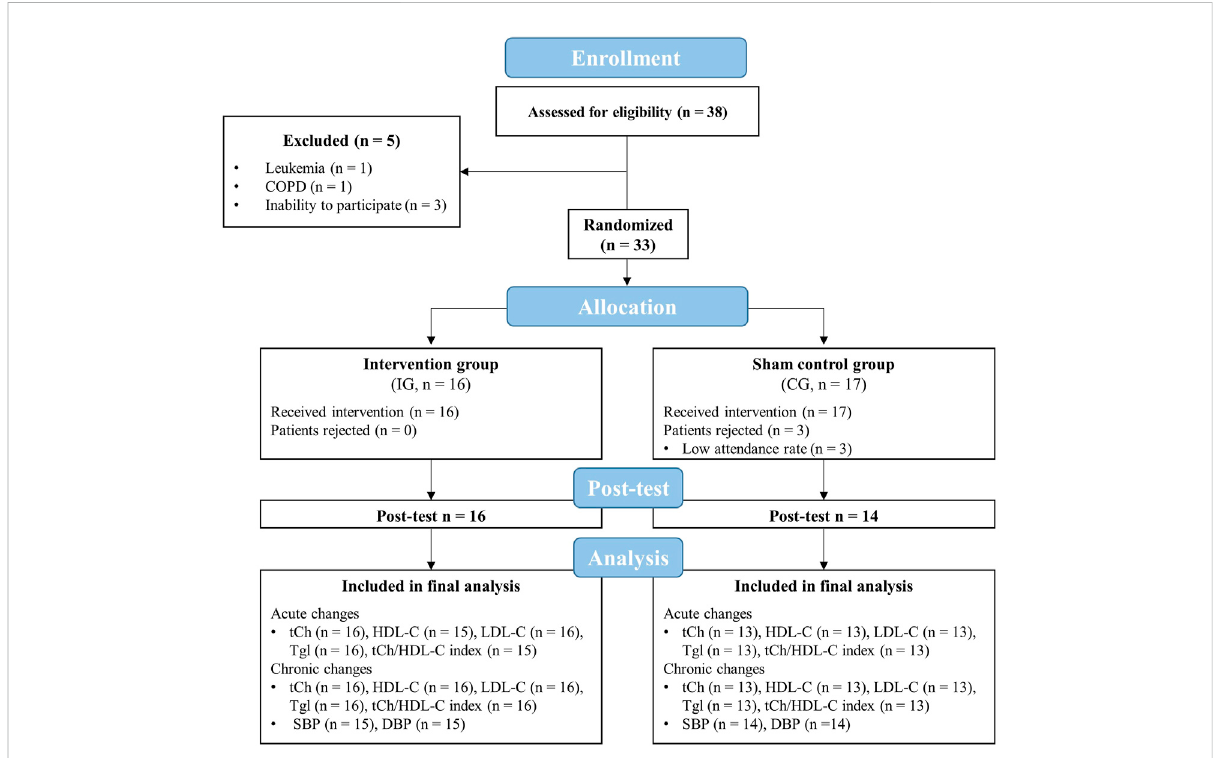
FIGURE 2 Flow chart of the study. CG, sham control group; COPD, chronic obstructive pulmonary disease; DBP, diastolic blood pressure; HDL-C, high- density lipoprotein cholesterol; IG, intervention group; LDL-C, low-density lipoprotein cholesterol; tCh, total cholesterol; Tgl, triglyceride; SBP, systolic blood